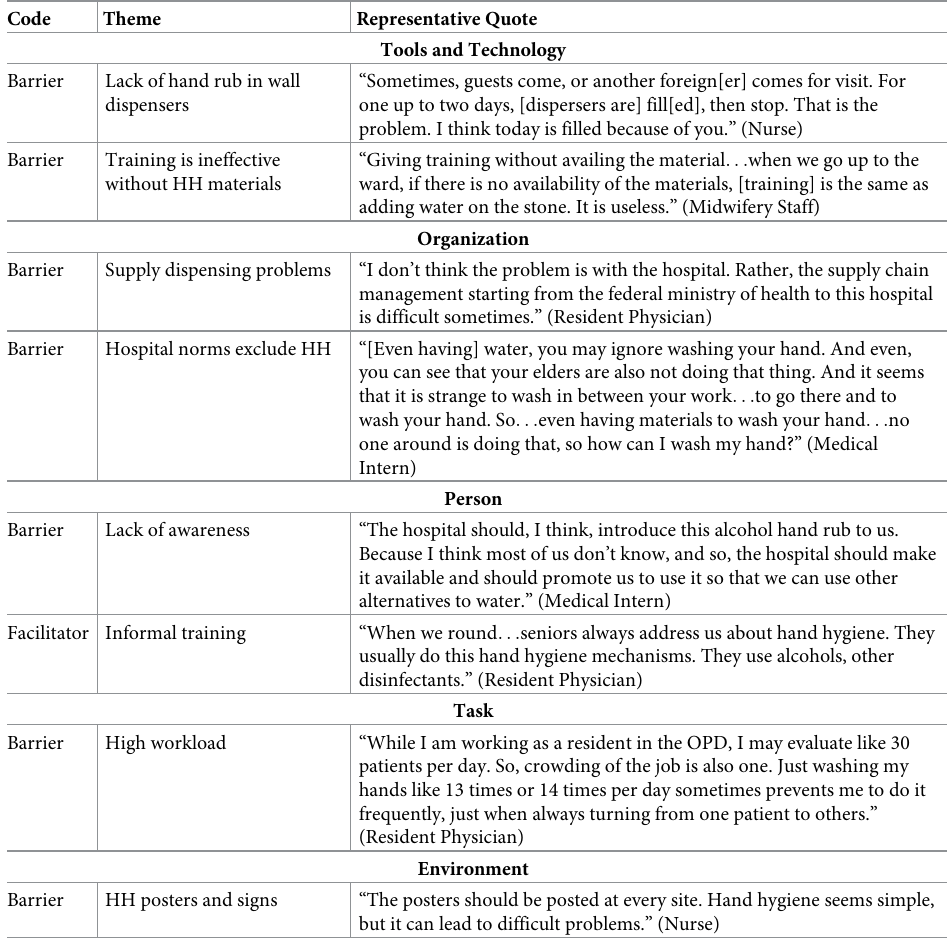
Table 4. Representative quotes of themes developed from qualitative responses with the 5 SEIPS